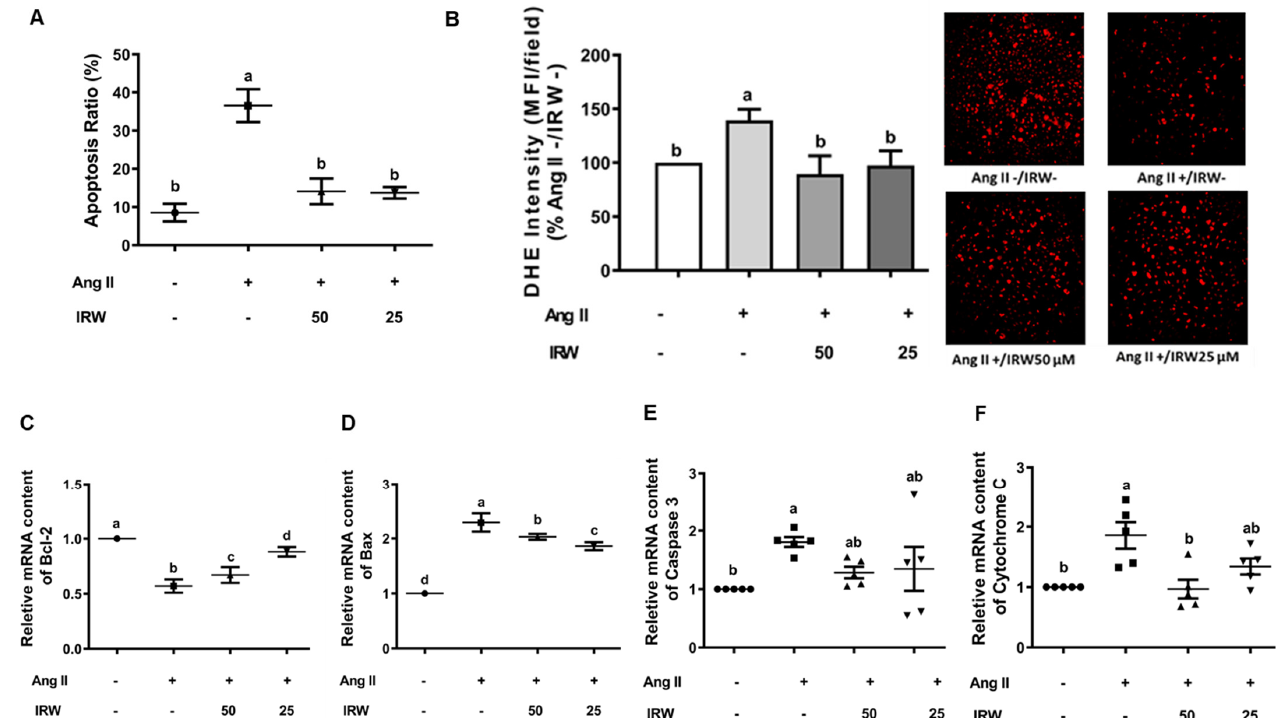
Figure 2. The effect of IRW on preventing osteoblast cell apoptosis against Ang II stimulation. Osteoblast cells MC3T3-E1 were pre-treated with IRW (50 μ M and 25 μ M) for 2 h prior to Ang II (1 μ M) and then co-cultured for 24 h. ( A ) Cells were collected, fixed, and the cell apoptosis rate was measured by flow cytometry; ( B ) DHE staining was performed to measure the levels of oxidative stress; ( C – F ) total RNA was extracted using TRIzol, converted to cDNA, and then the gene expression of mitochondrial apoptotic markers ( C ) Bcl-2, ( D ) Bax, ( E ) Caspase 3, and ( F ) Cytochrome C was measured by qPCR (quantitative PCR). All results are representative of 4~6 independent experiments and expressed as mean ± SEM. Mean without a common letter indicated p < 0.05.